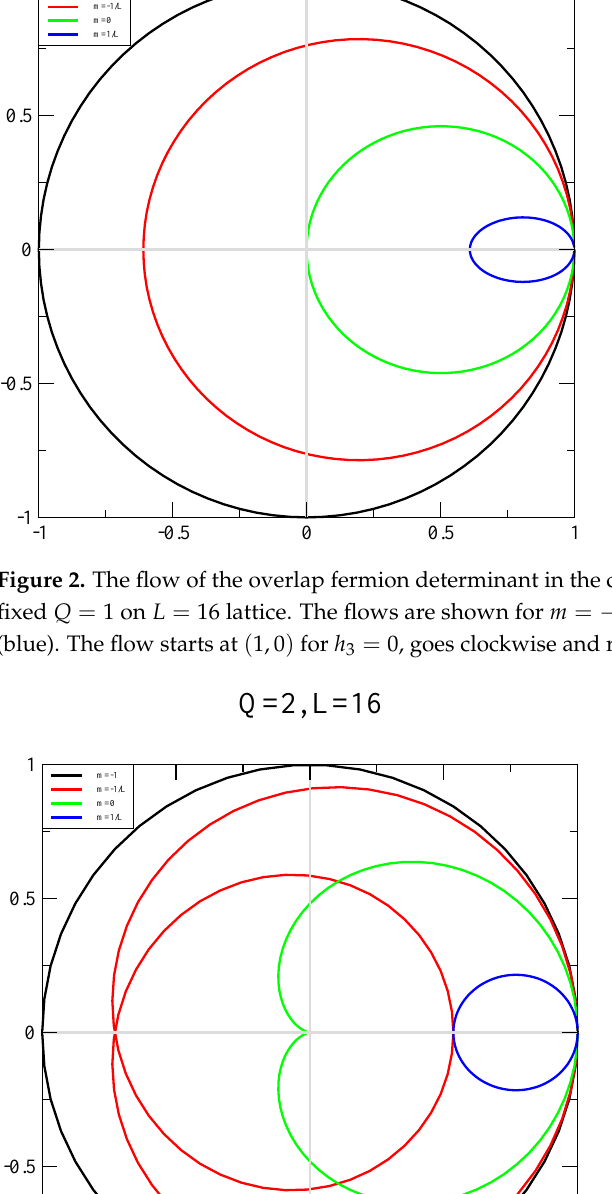
Figure 3. The flow of the overlap fermion determinant in the complex plane as a function of h 3 at a fixed Q = 2 on L = 16 lattice. The description is the same as in Figure